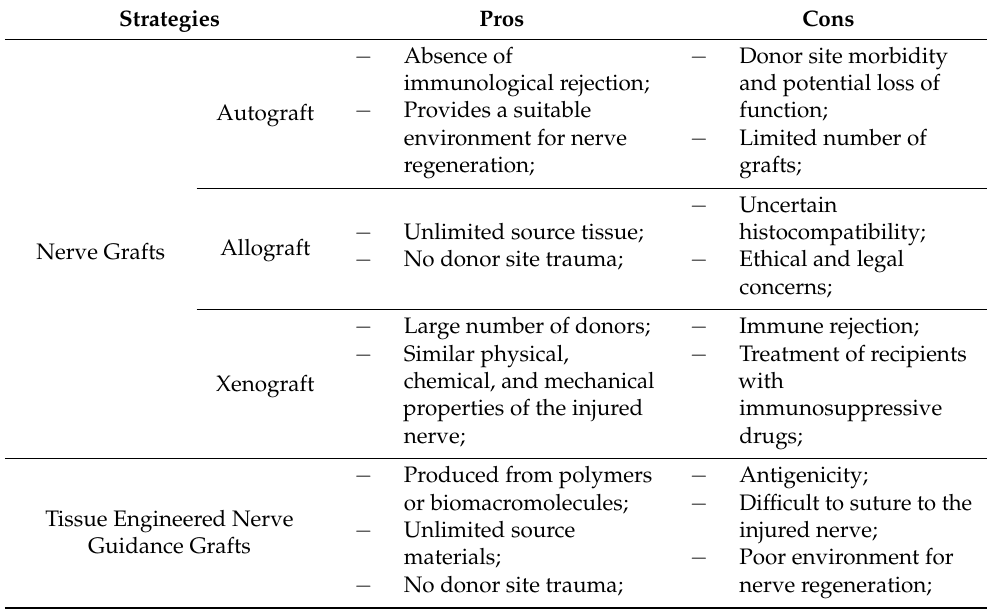
Table 1. Strategies applied in nerve regeneration, underlining the pros and cons a . Strategies Pros Cons − Absence Autograft